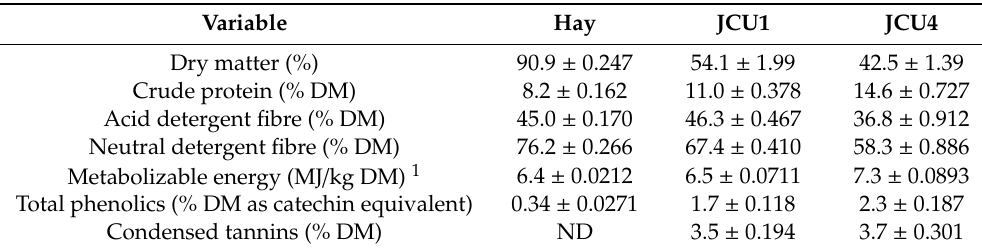
Table 1. Chemical composition (means ± s.e.) of the Rhodes grass hay and the two cultivars of Desmanthus (JCU1 and JCU4).